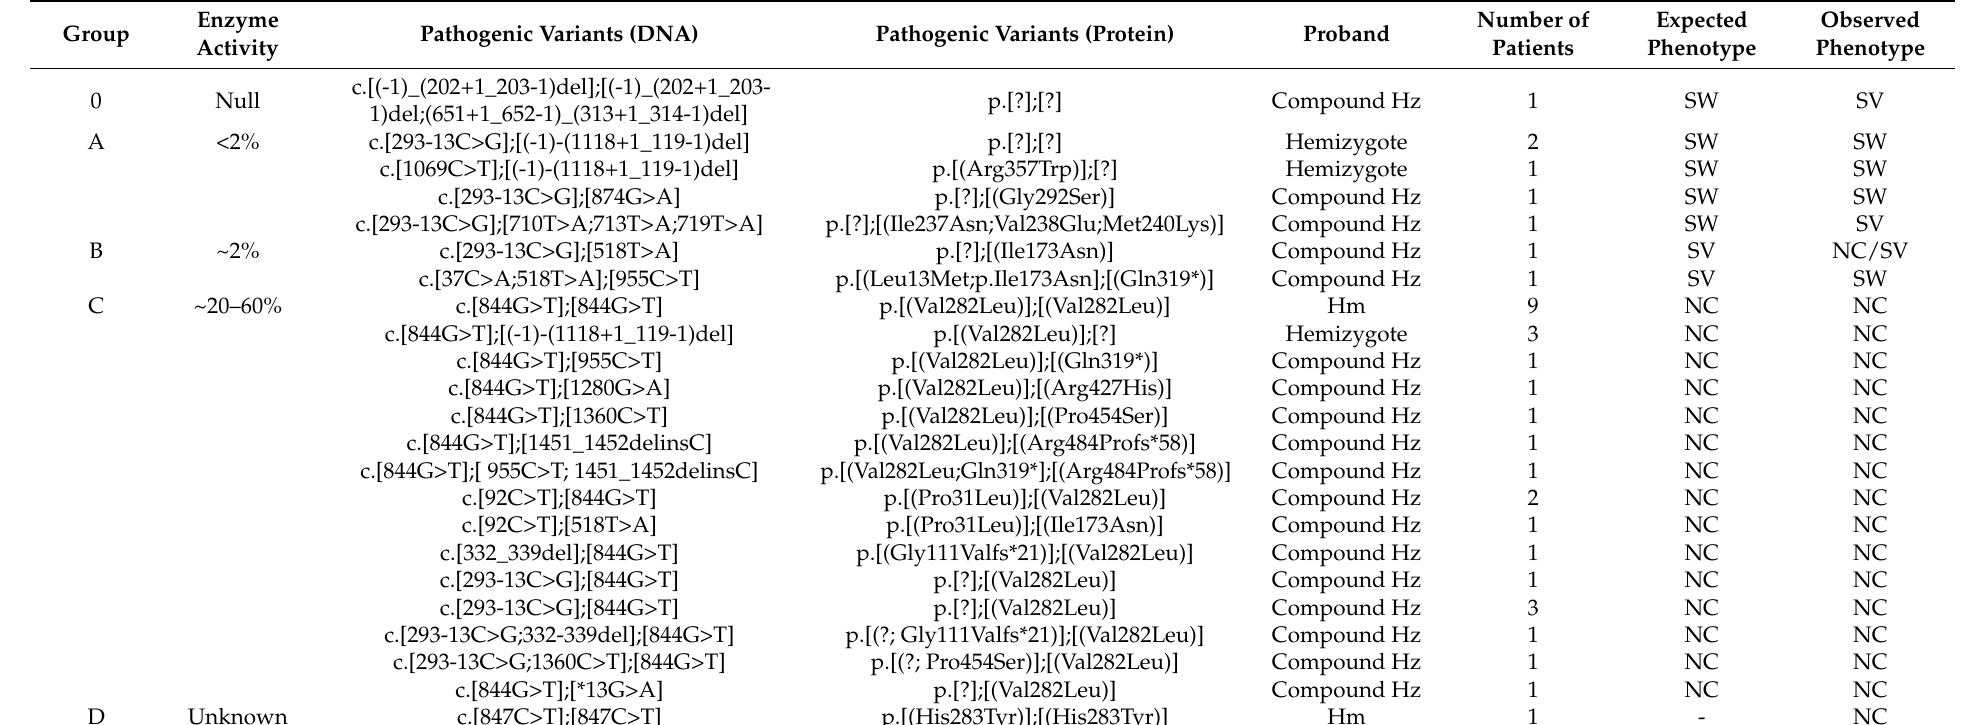
Table 2. Genotype and expected and observed phenotypes in genetically confirmed